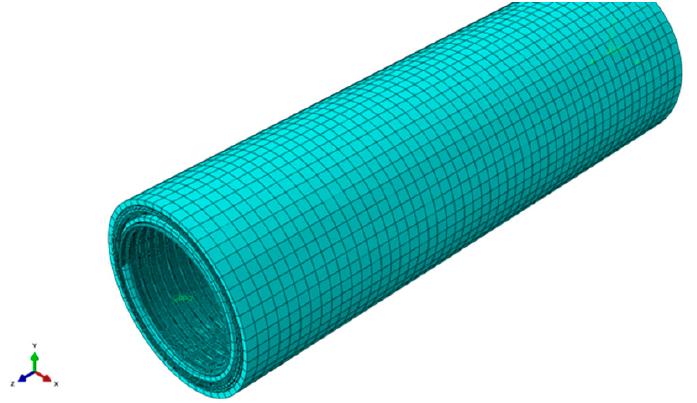
Figure 4. A finite element model of a multilayer flexible riser.